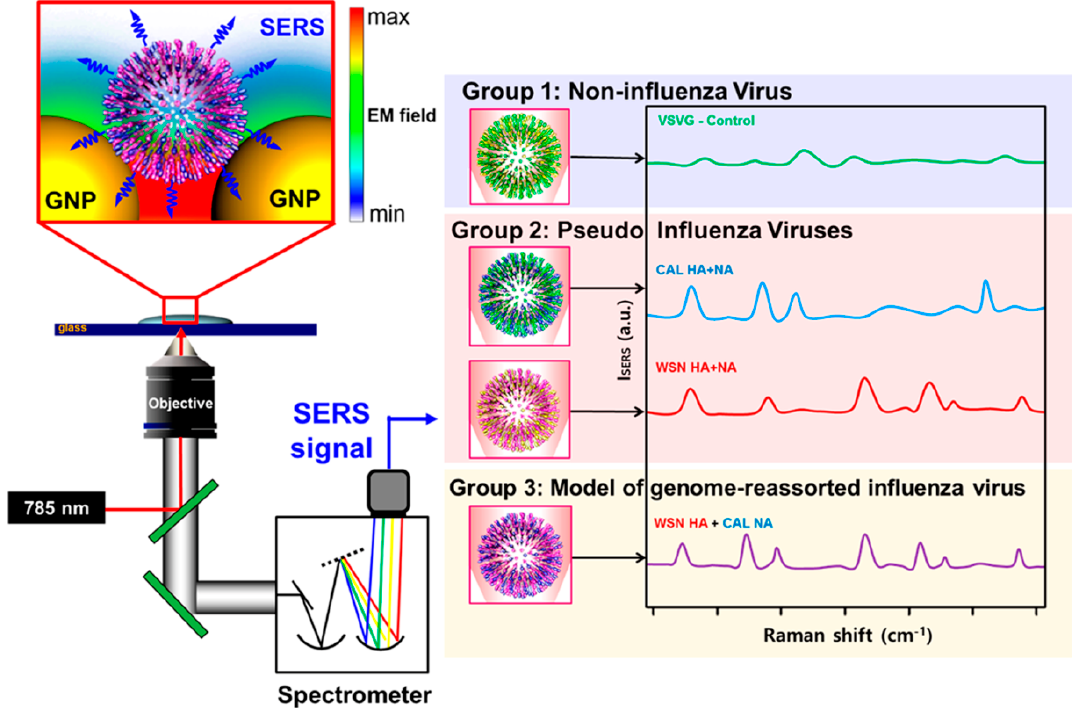
Figure 6. Schematic of the rapid detection of influenza viruses via SERS [160]. Reproduced with permission from [160]. American Chemical Society, 2015.